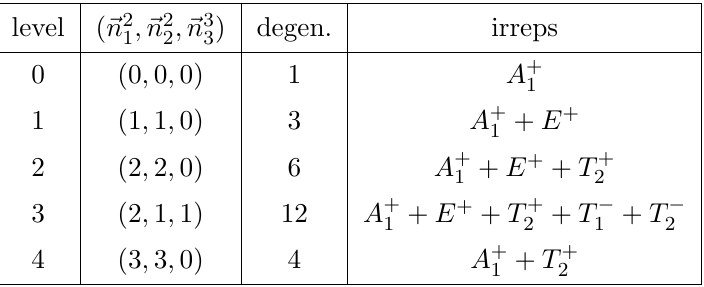
Table 2. Irreps appearing in the lowest energy levels of three identical noninteracting particles. The (cid:12)rst column gives the level number (for values of mL 5), starting at zero. The states are (cid:24) labeled by the squares of the three vectors ~n i that determine the momenta of the particles | see eq. (3.23) | and these are given in the second column. The third column gives the degeneracy, and the (cid:12)nal column the irreps that